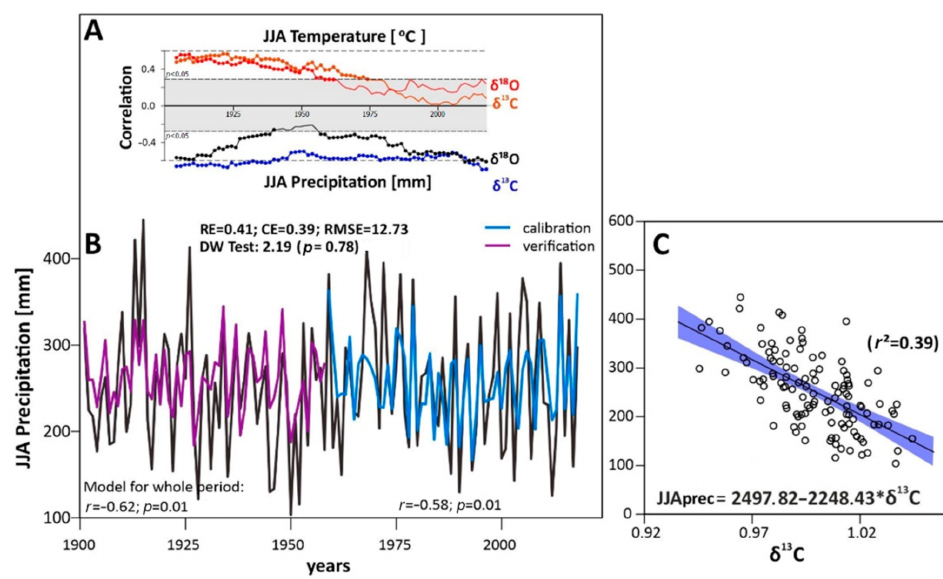
Figure 5. ( A ) Moving correlation analysis between tree-ring stable isotopes and JJA precipitation sum and mean JJA temperature. Correlation coefficients were calculated over 45-year periods and plotted on the central year. ( B ) Calibration-verification model for the JJA precipitation sum for the period 1901–2018. ( C ) Scatter plot of summer (JJA) precipitation sum (JJAprec; mm) and δ 13 C over the whole period 1901–2018. Abbreviations: RE (reduction error), CE (coefficient of efficiency), RSME (root mean square error), DW (Durbin-Watson statistics), r 2 (squared Pearson’s correlation